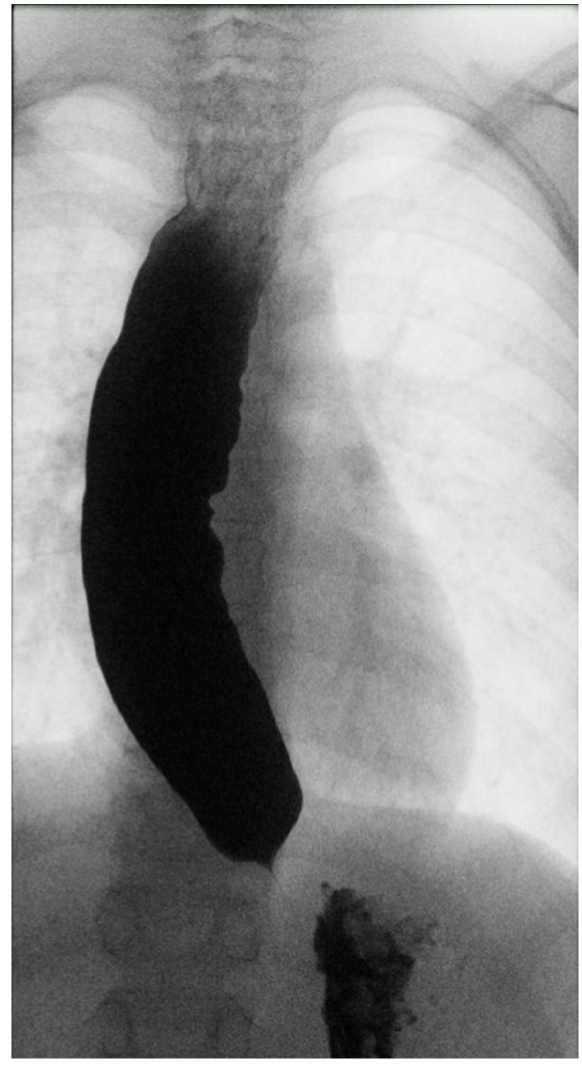
Children 2022 , 9 , x FOR PEER REVIEW Figure 1. Esophageal barium swallow. Figure 1. Esophageal barium swallow.